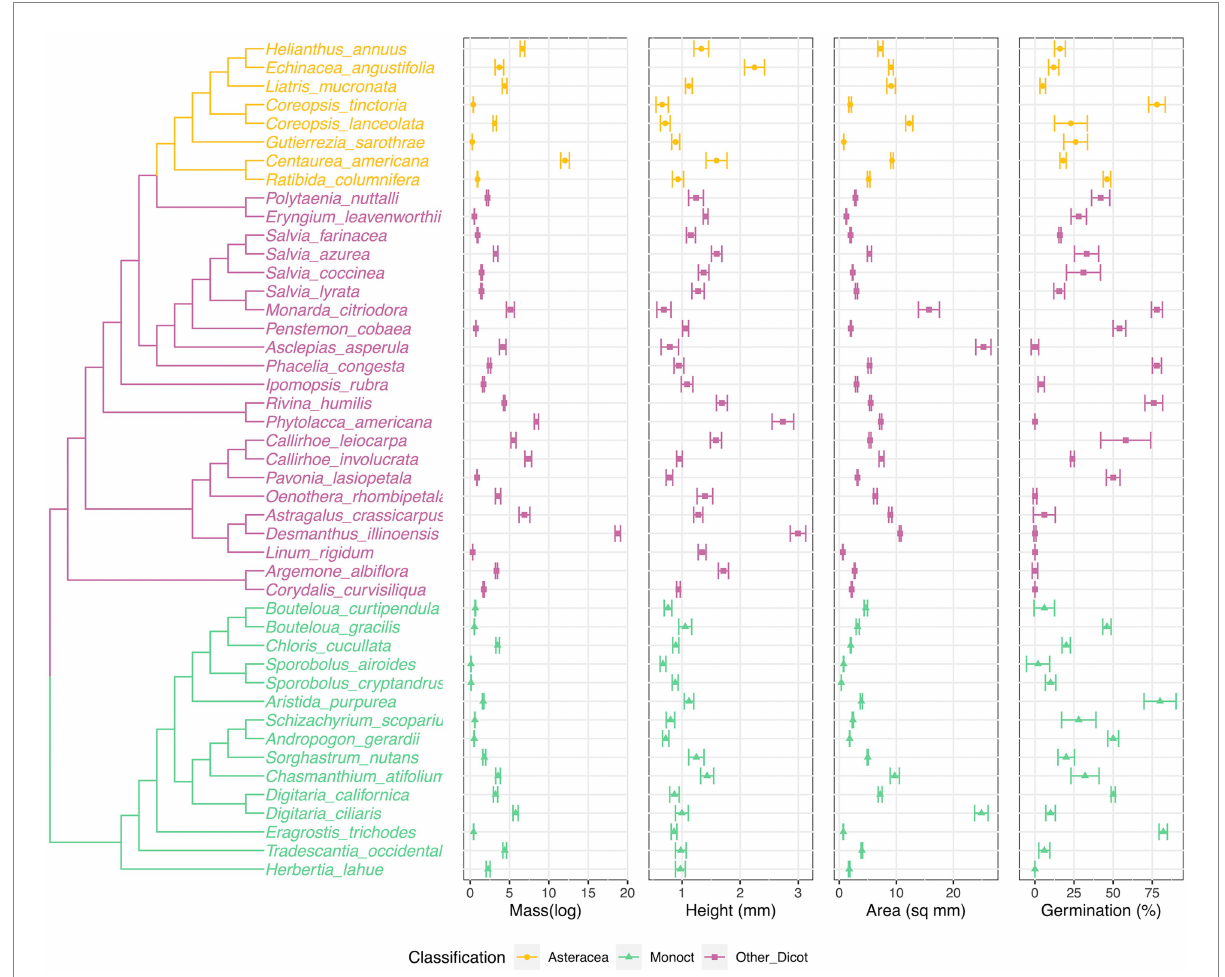
FIGURE 1 Phylogenetic tree of species and species seed traits values (seed mass, seed height) distribution along the phylogenetic tree. Phylogenetic tree was generated from the pruned Zanne et al. tree (Zanne et al. 2014), including 15 species ( Astragalus crassicarpus , Argemone albiflora , Asclepias Asperula , Callirhoe leiocarpa , Centaurea americana , Chasmanthium tifolium , Corydalis curvisiliqua , Digitaria californica , Eragrostis trichodes , Herbertia lahue , Linum rigidum , Pavonia lasiopetala , Polytaenia nuttallii , Tradescantia occidentalis , Liatris mucronata ) were placed within under the same genus/family. The center of each plot is the mean value, the other two lines are − /+ standard errors. The colors were coded corresponding to the grouping of phylogenetic positions (Figure